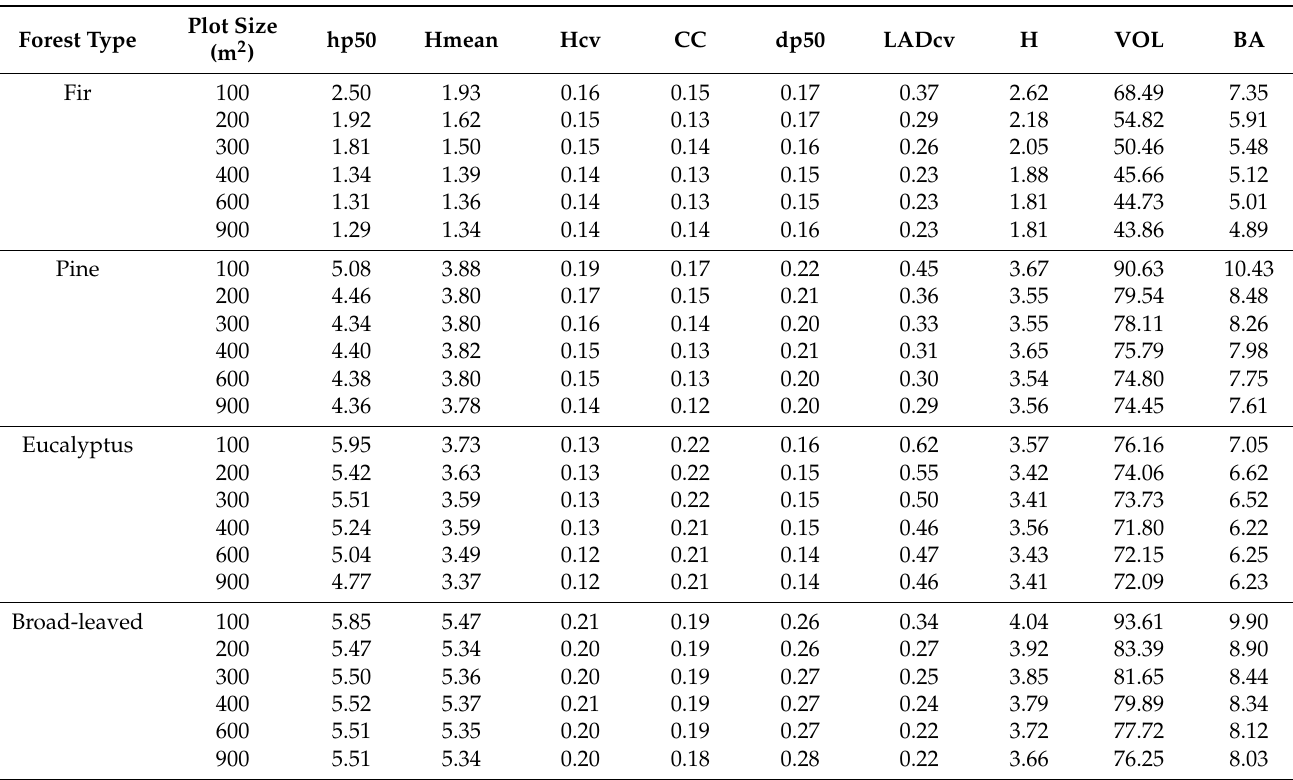
Table 3. Standard deviations of some LiDAR-derived metrics and measured forest attributes for field plots of different